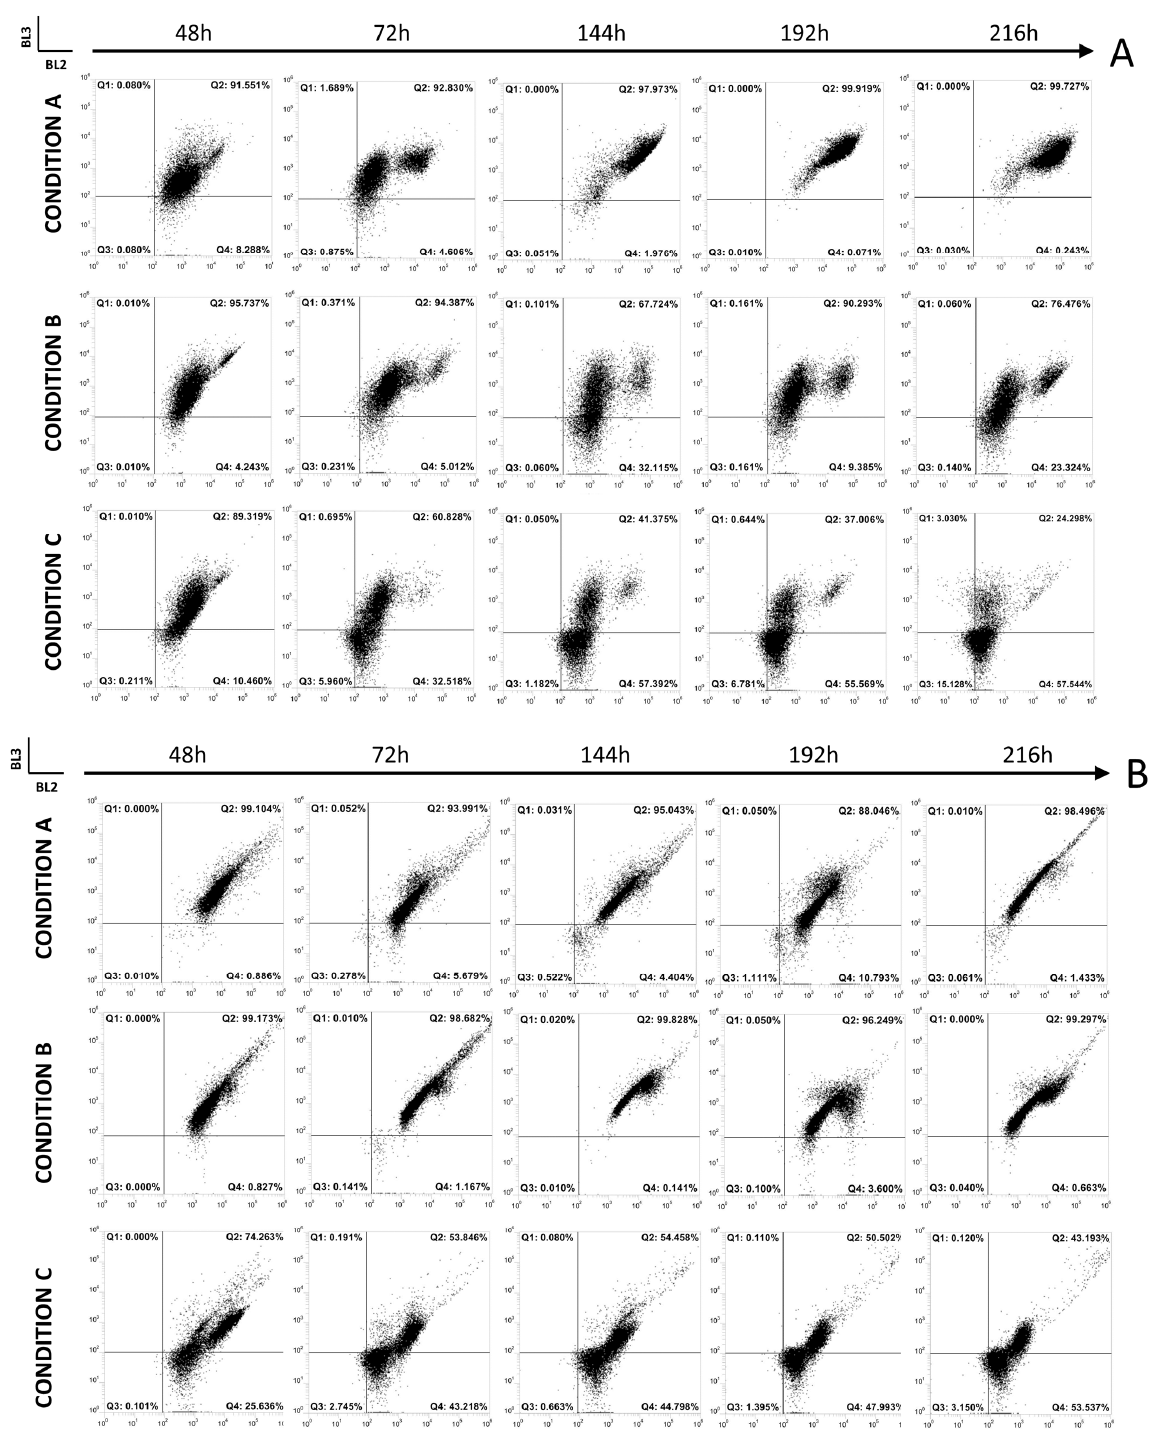
Figure 3. Nile red fluorescence intensities (BL-2 and BL-3) of yeast cells over time for small-scale cultures (( A ): YNB at initial pH 4.5, ( B ): YNB at initial pH 7, and C: YNB in 0.4 M Tris-HCl buffer at